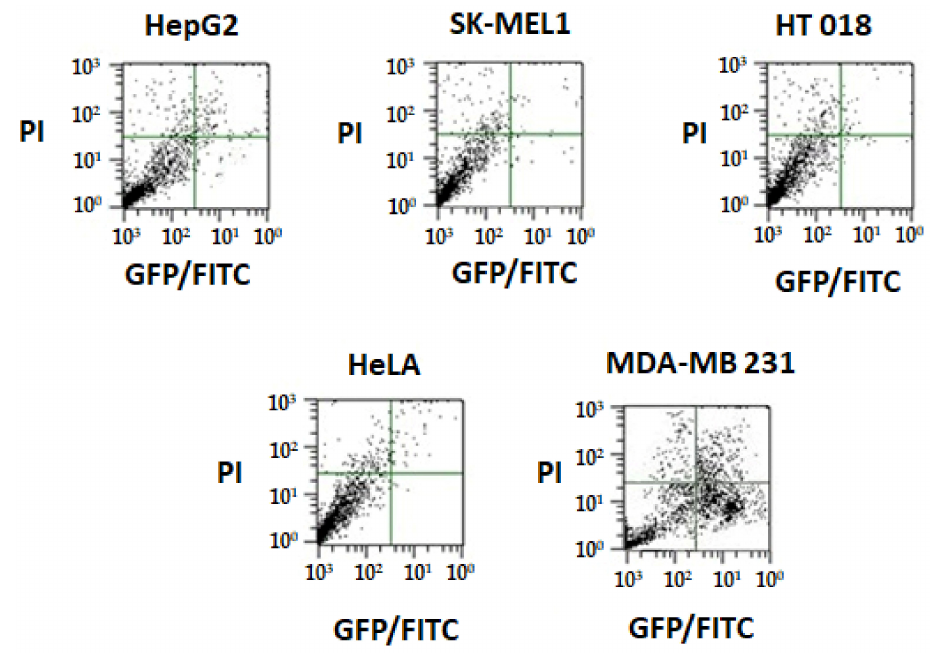
Figure 9. The apoptotic effect of complex 1 using annexin-V staining of tested cancer cell lines. Dots represent cells as follows: lower left quadrant, normal cells (FITC − /PI − ); lower right quadrant, early apoptotic cells (FITC + /PI − ); upper left quadrant, necrotic cells (FITC − /PI + ); upper right quadrant, late apoptotic cells (FITC + /PI +